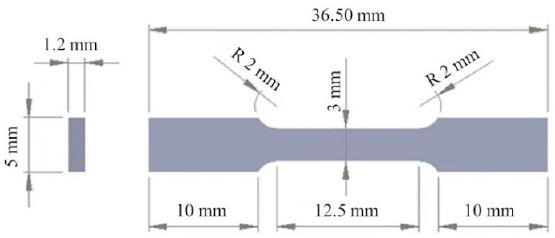
Figure 3. Dimensions of miniature tensile test specimens used in dilatometry experiments.